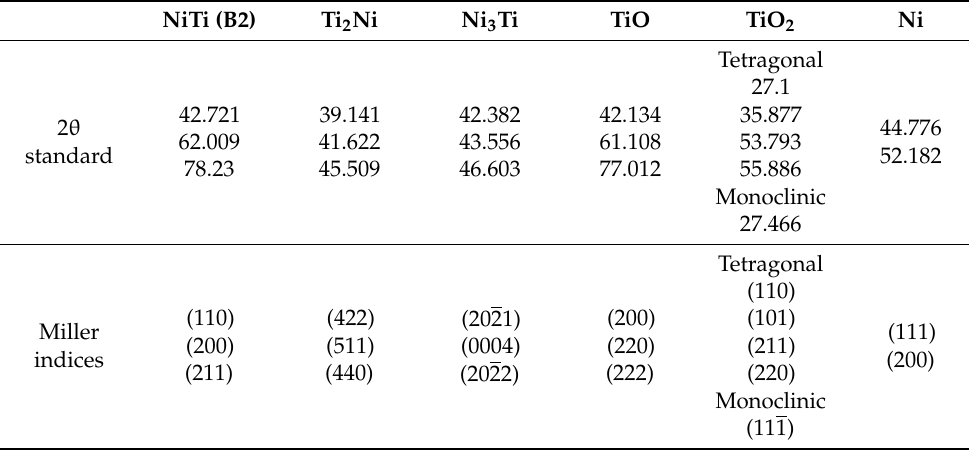
Table 2. Standard 2 θ angles and Miller indices of the identified